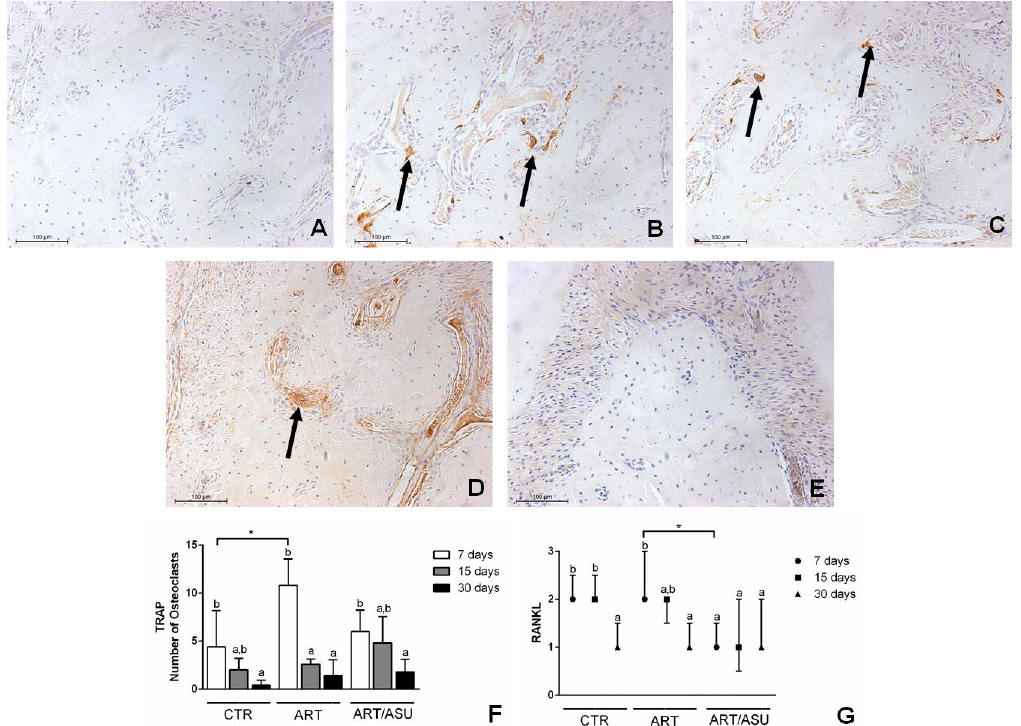
Figure 5- Representative images and graphs of the analysis of TRAP and RANKL expression. A) Negative control; B) TRAP expression in the ART group at 7 days; C) TRAP expression in the CTR group at 7 days. It was shown that the TRAP expression was verified in osteoclast cells that were in the vicinity of the bone tissue (black arrows); D) RANKL expression in the ART group at 7 days; E) RANKL expression at the ART/ASU group at 7 days. The RANKL expression was noted in cells close to the bone tissue or associated with cells in the vicinity of the blood vessels (Black arrows). F) TRAP: Compared with the CTR group at 7 days, a higher expression of TRAP positive cells was shown in the ART group. *p<0.05 – Significant differences between the groups – One-way ANOVA complemented by Tukey‘s test; Different letters represent different levels of significant differences within each group – One-way ANOVA complemented by Tukey‘s test. G) RANKL: Compared with the ART/ASU group, a higher expression of RANKL was observed in the ART group at the period of 7 days. *p<0.05 – Significant differences between the groups – Kruskall-Wallis complemented by Dunn's test; Different letters represent different levels of significant differences within each group – Kruskall-Wallis complemented by Dunn‘s test. (Original augmentation